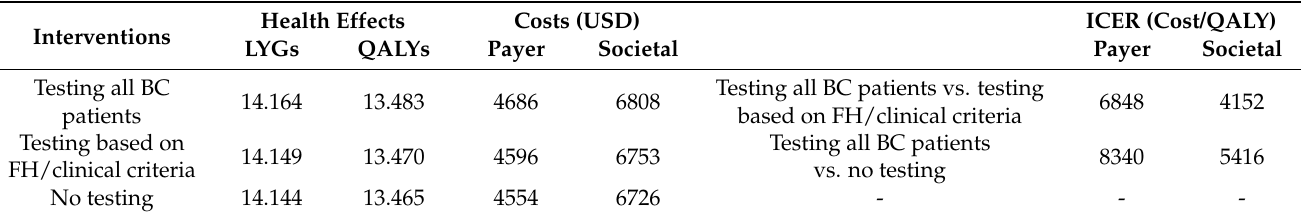
Table 1. Lifetime discounted costs, effects and ICER before dominance principle